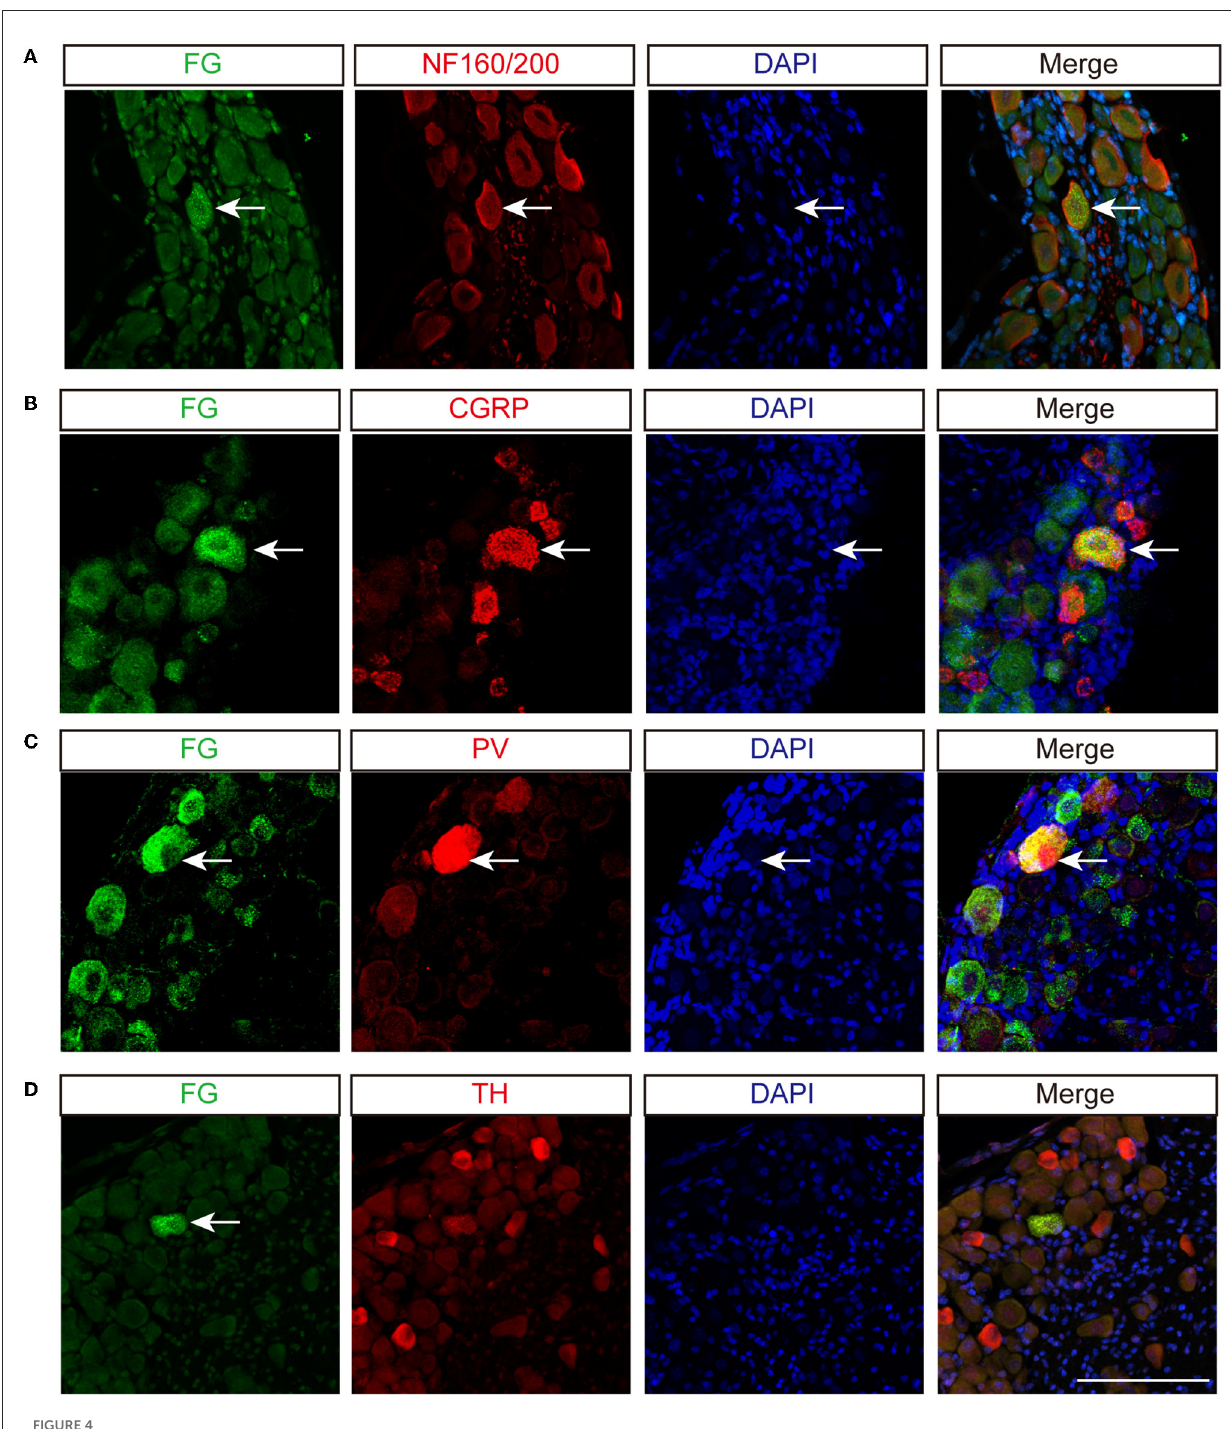
FIGURE4 Sensory innervation of L5/6 disk in mice. Immunofluorescence labeling of FG with NF160/200 (A) , CGRP (B) , PV (C) , and TH (D) in DRG. Arrows indicate co-labeled neurons. Scale bar: 100 µ m.